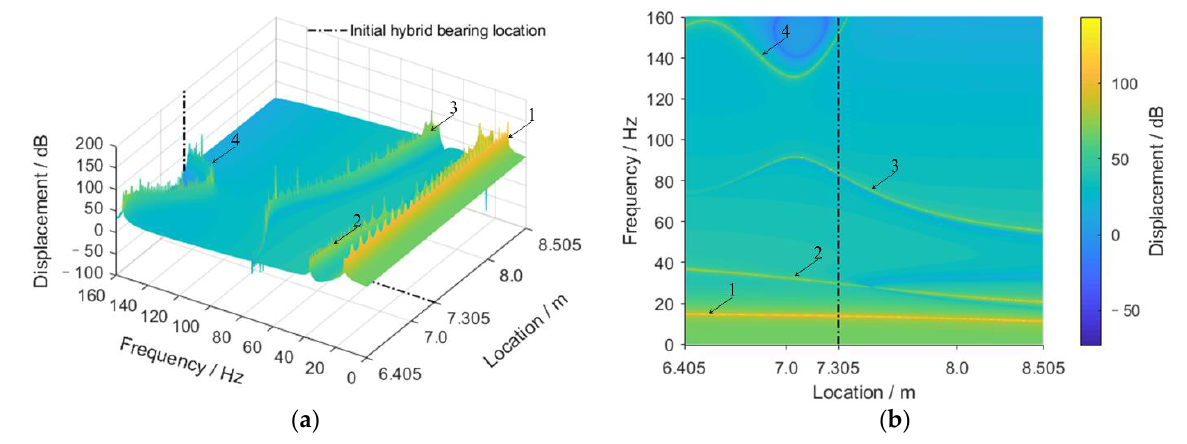
Figure 7. Transverse vibration under different hybrid bearing locations. ( a , b ) are the vibration response at x = 0 m. ( b ) is the top view. Numbers and arrows are used to mark the order of the resonance.